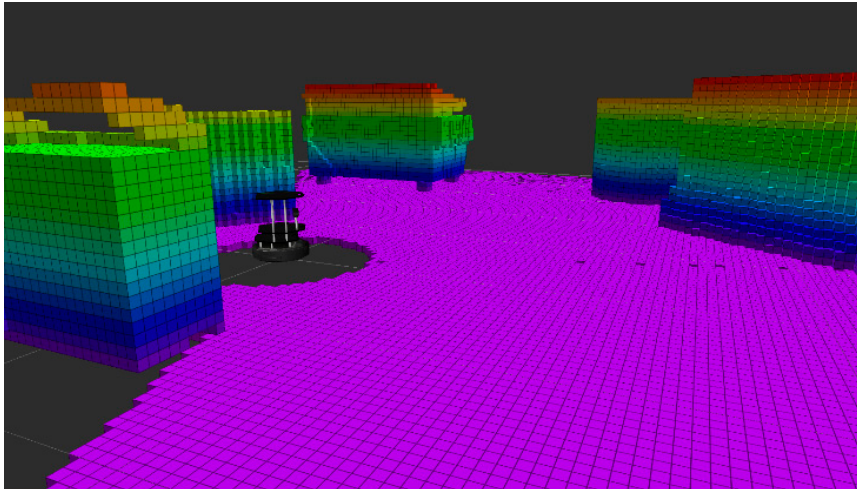
Figure 3. Visualisation of simulated TurtleBot Kinect sensor point cloud in RViz [22], post-processed using OctoMap [15] method available in ROS OctoMap package.